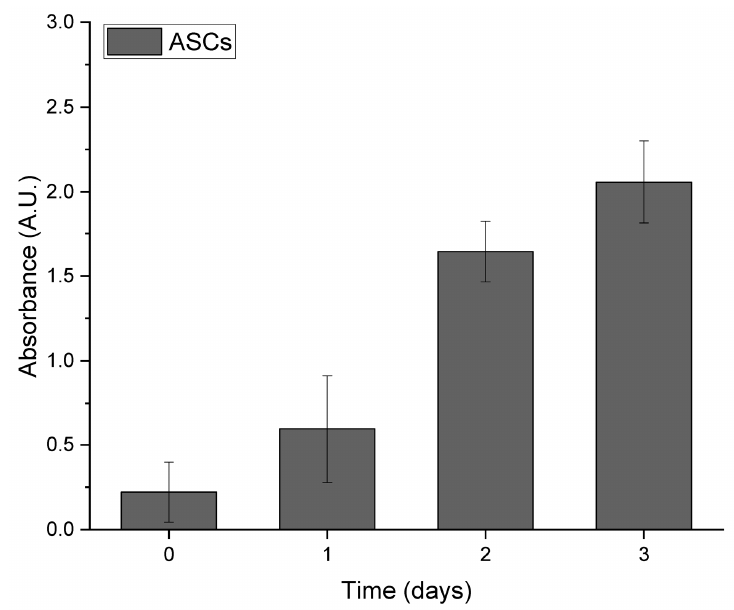
Figure 1. Growth of adipose-derived stromal cells (ASCs) seeded on Integra ® DRT over long-term